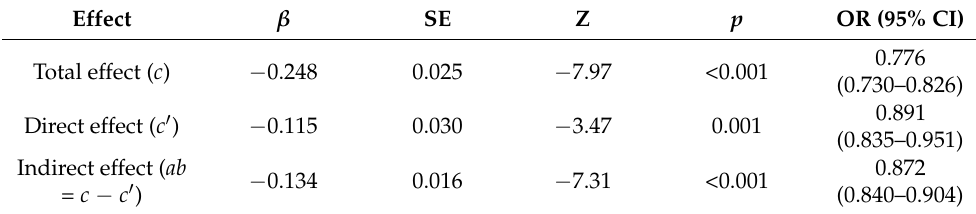
Table 4. Models of the mediating role of social support in the relationship between health literacy and depressive